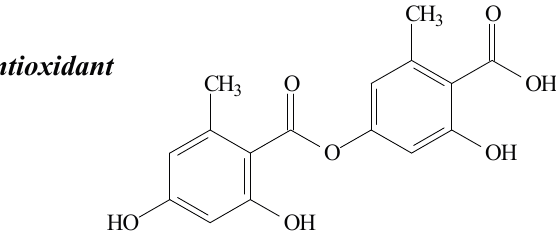
Figure 4. Lecanoric acid structure and biological